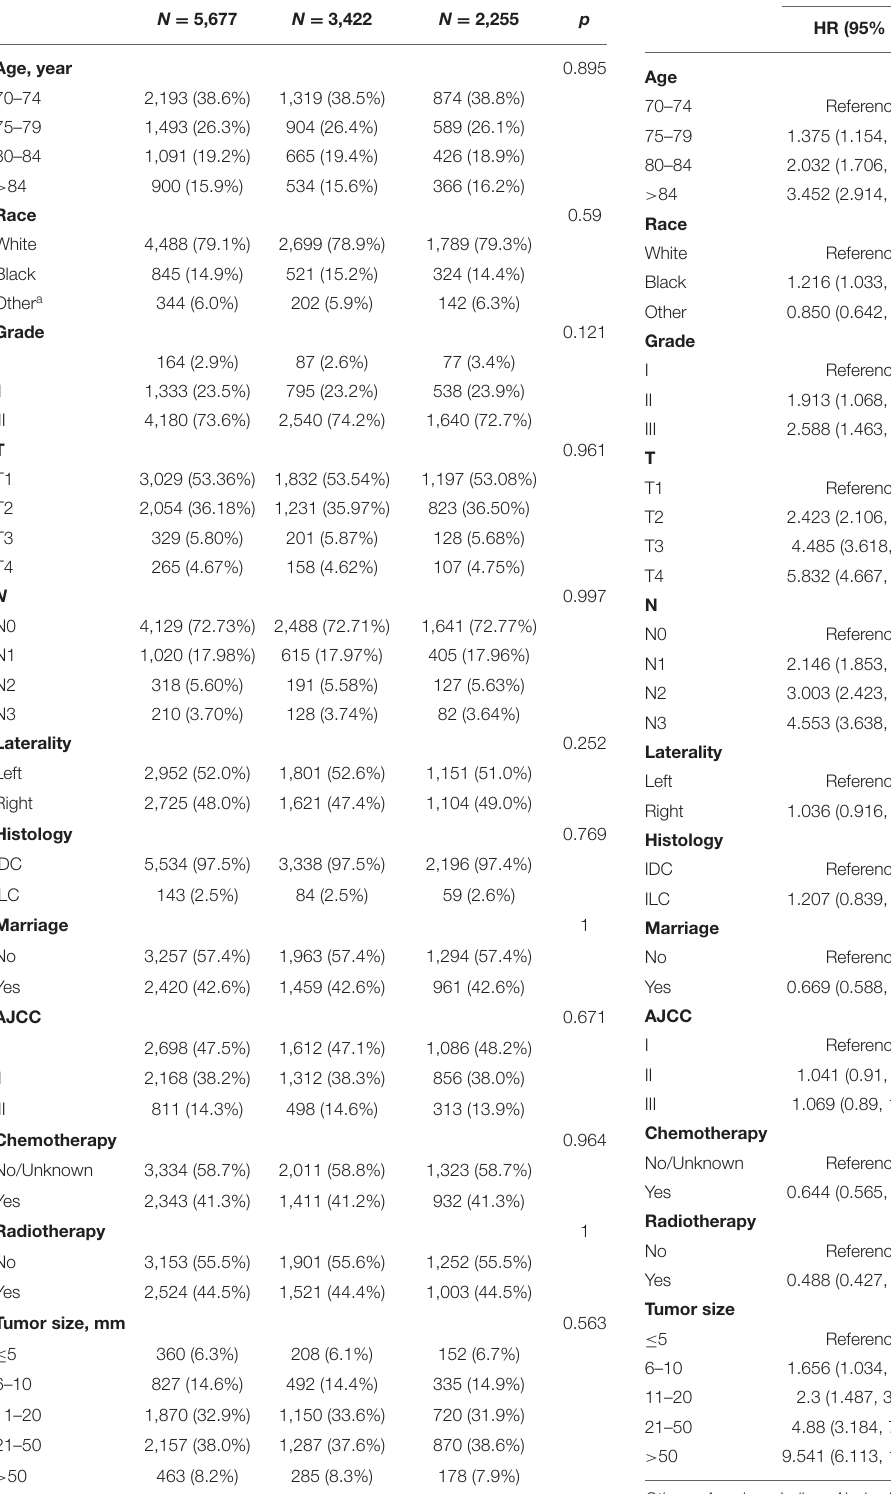
TABLE 1 | Clinicopathological characteristics of patients with triple-negative breast cancer (TNBC) in the present study. Characteristics